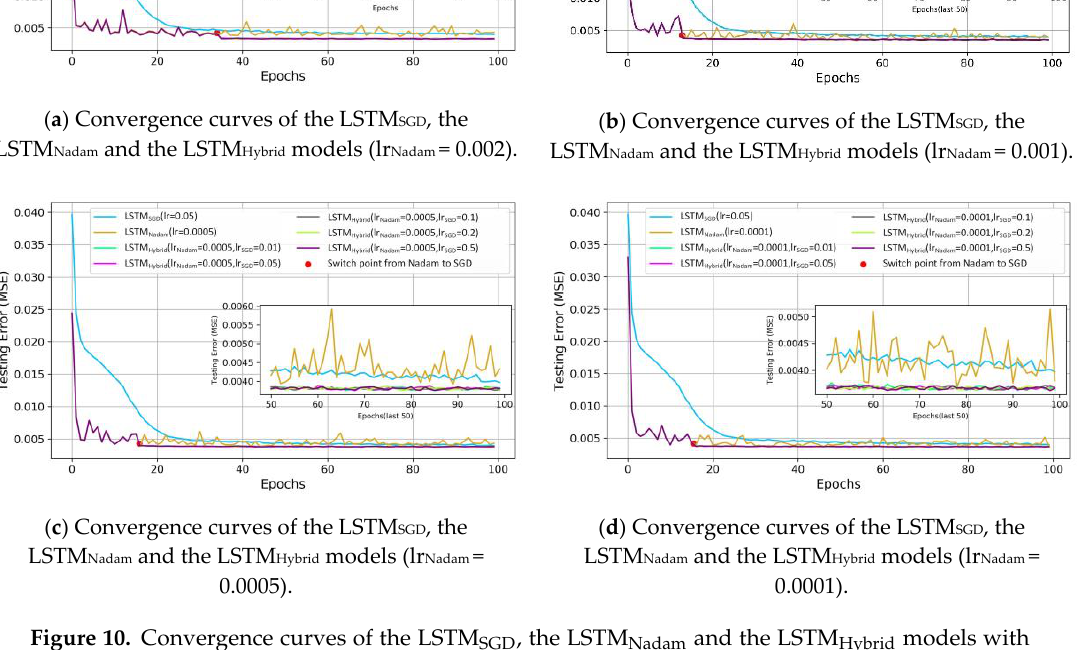
Figure 11. Loss (MSE) of LSTM SGD , LSTM Nadam and LSTM Hybrid models.